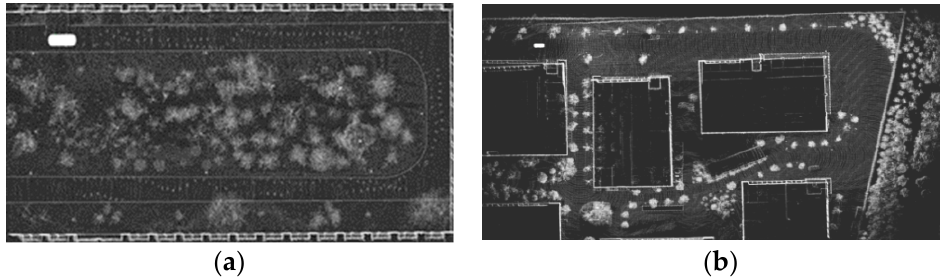
Figure 13. Environment map. ( a ) Simple environment map ( b ) Complex environment map.